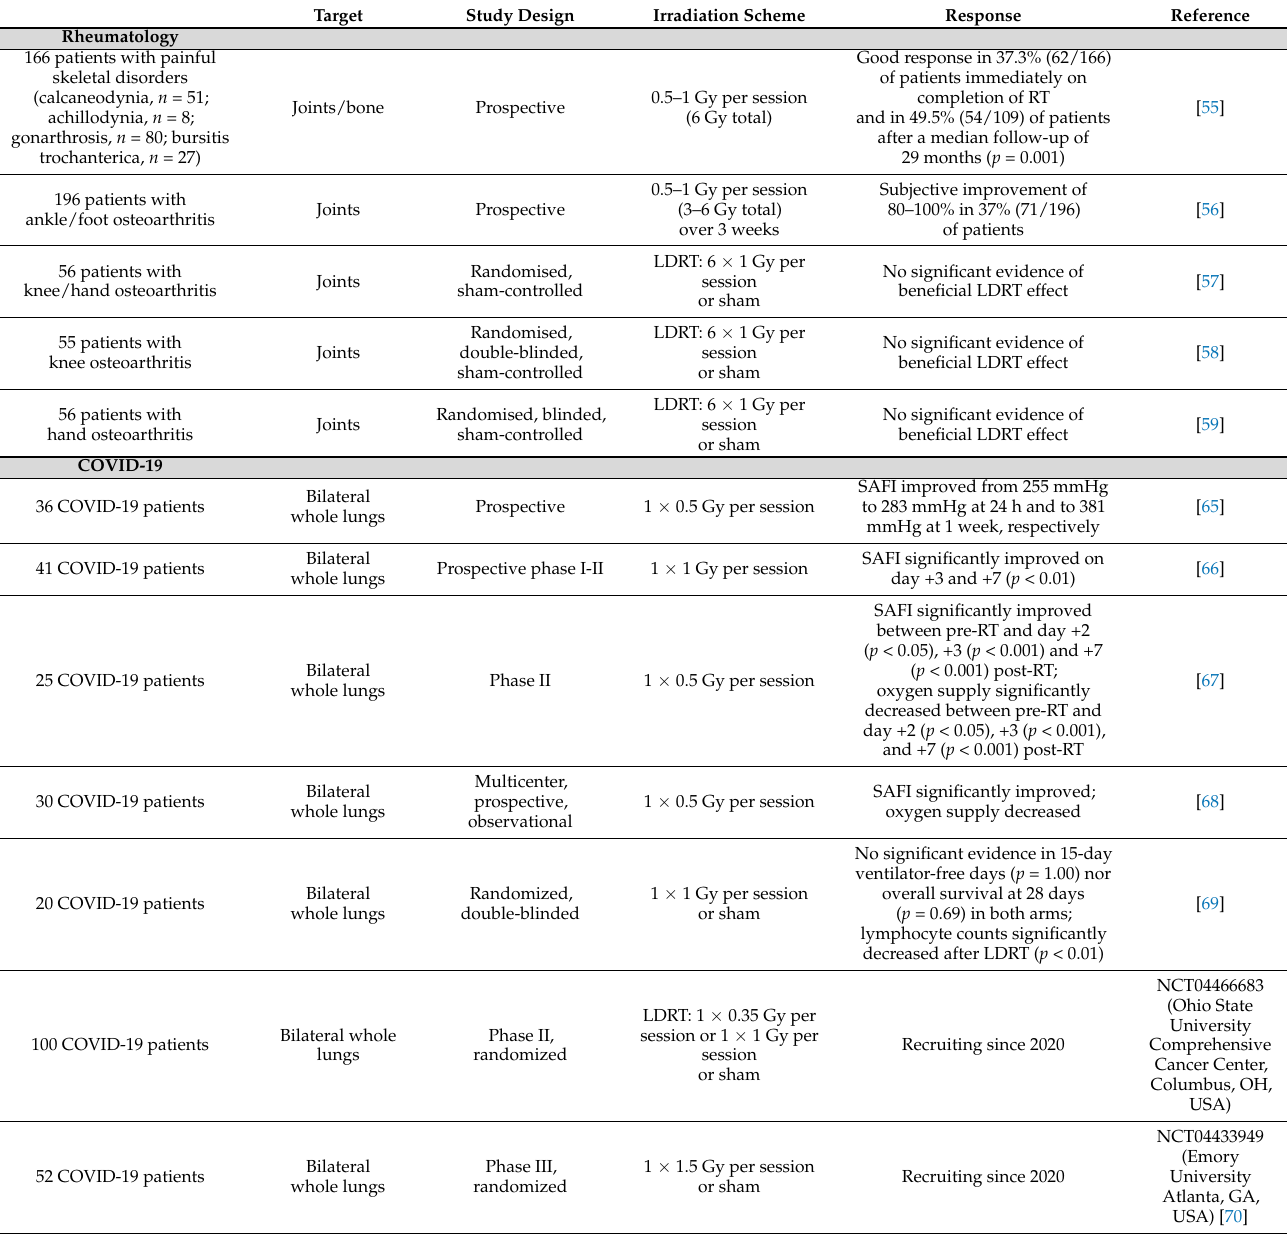
Table 2. State of the art of low-dose radiation therapy (LDRT) in inflammation-related pathologies.